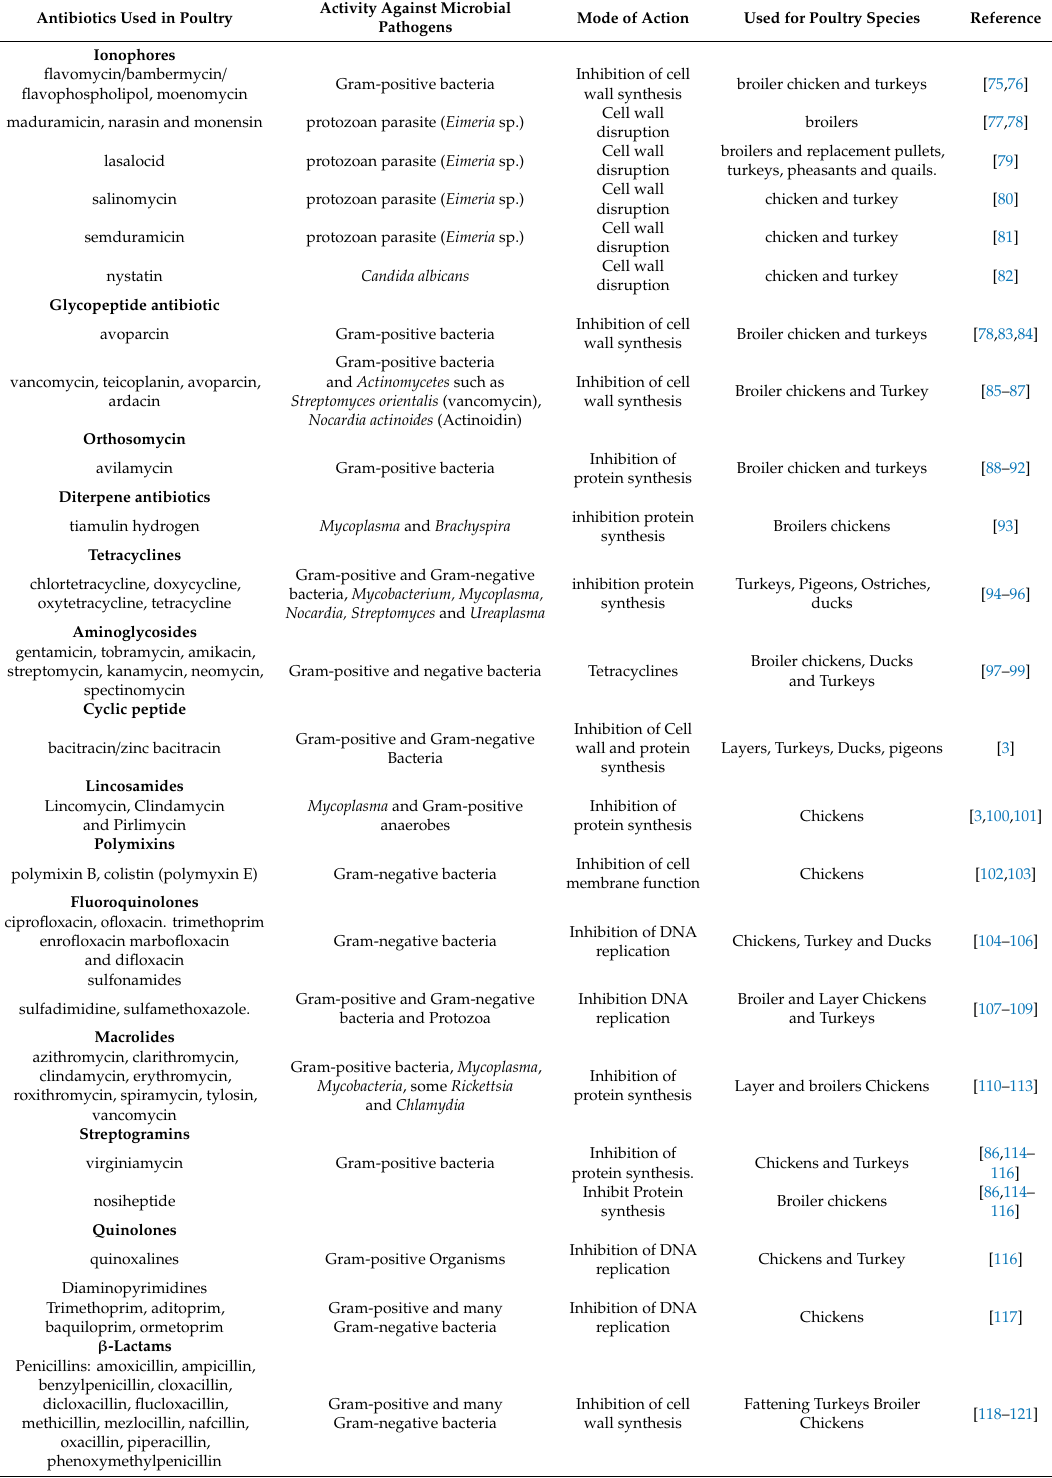
Table 2. Antibiotics used in poultry industry for the treatment of microbial diseases and also as feed additives as antibiotic growth promoters